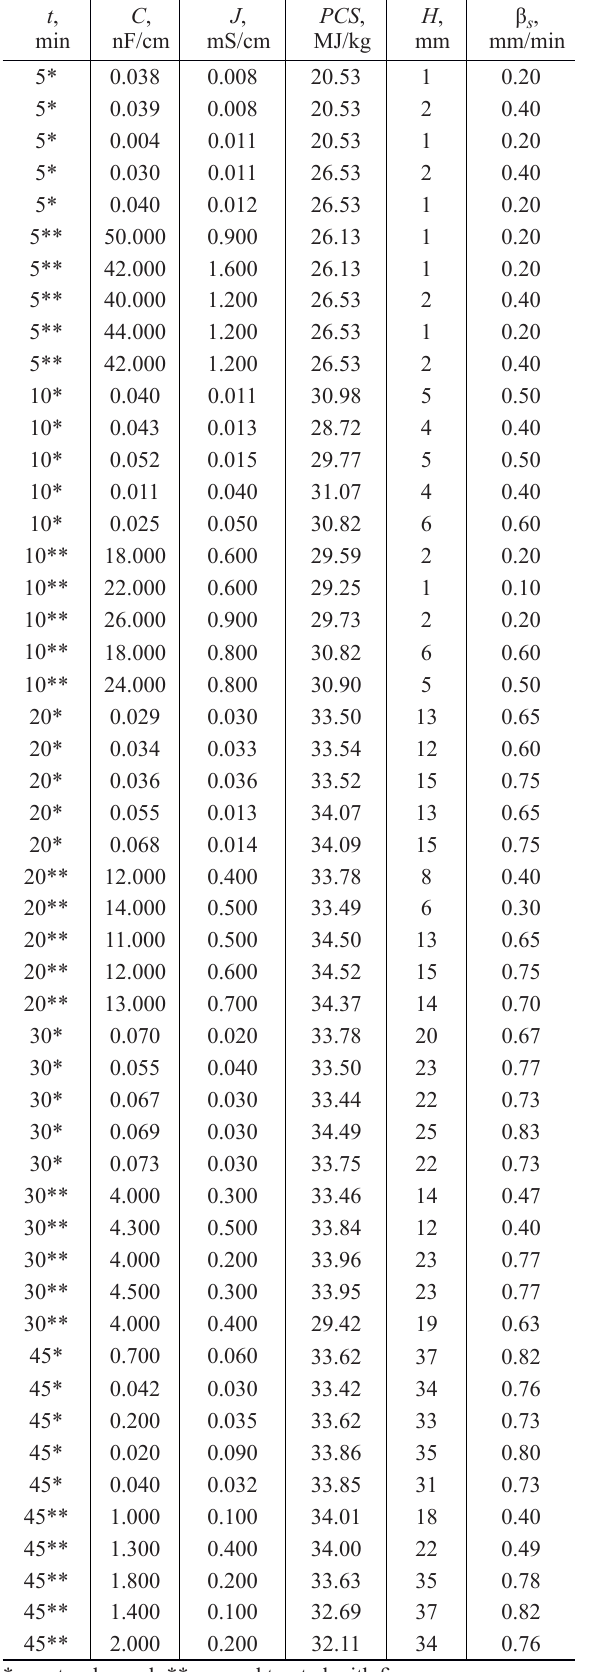
Table 1. Characteristic data of research carried out Table 2. Pair correlation matrix of carbonic residual specimen group of natural wood